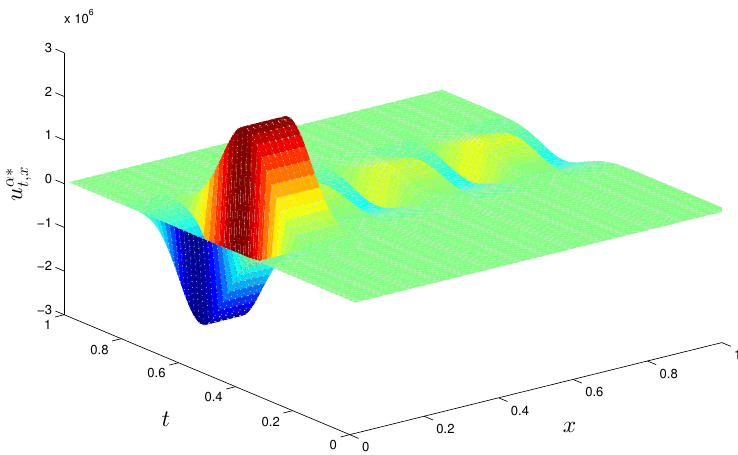
Figure 4. u α ∗ with respect to t and x for α = t , x